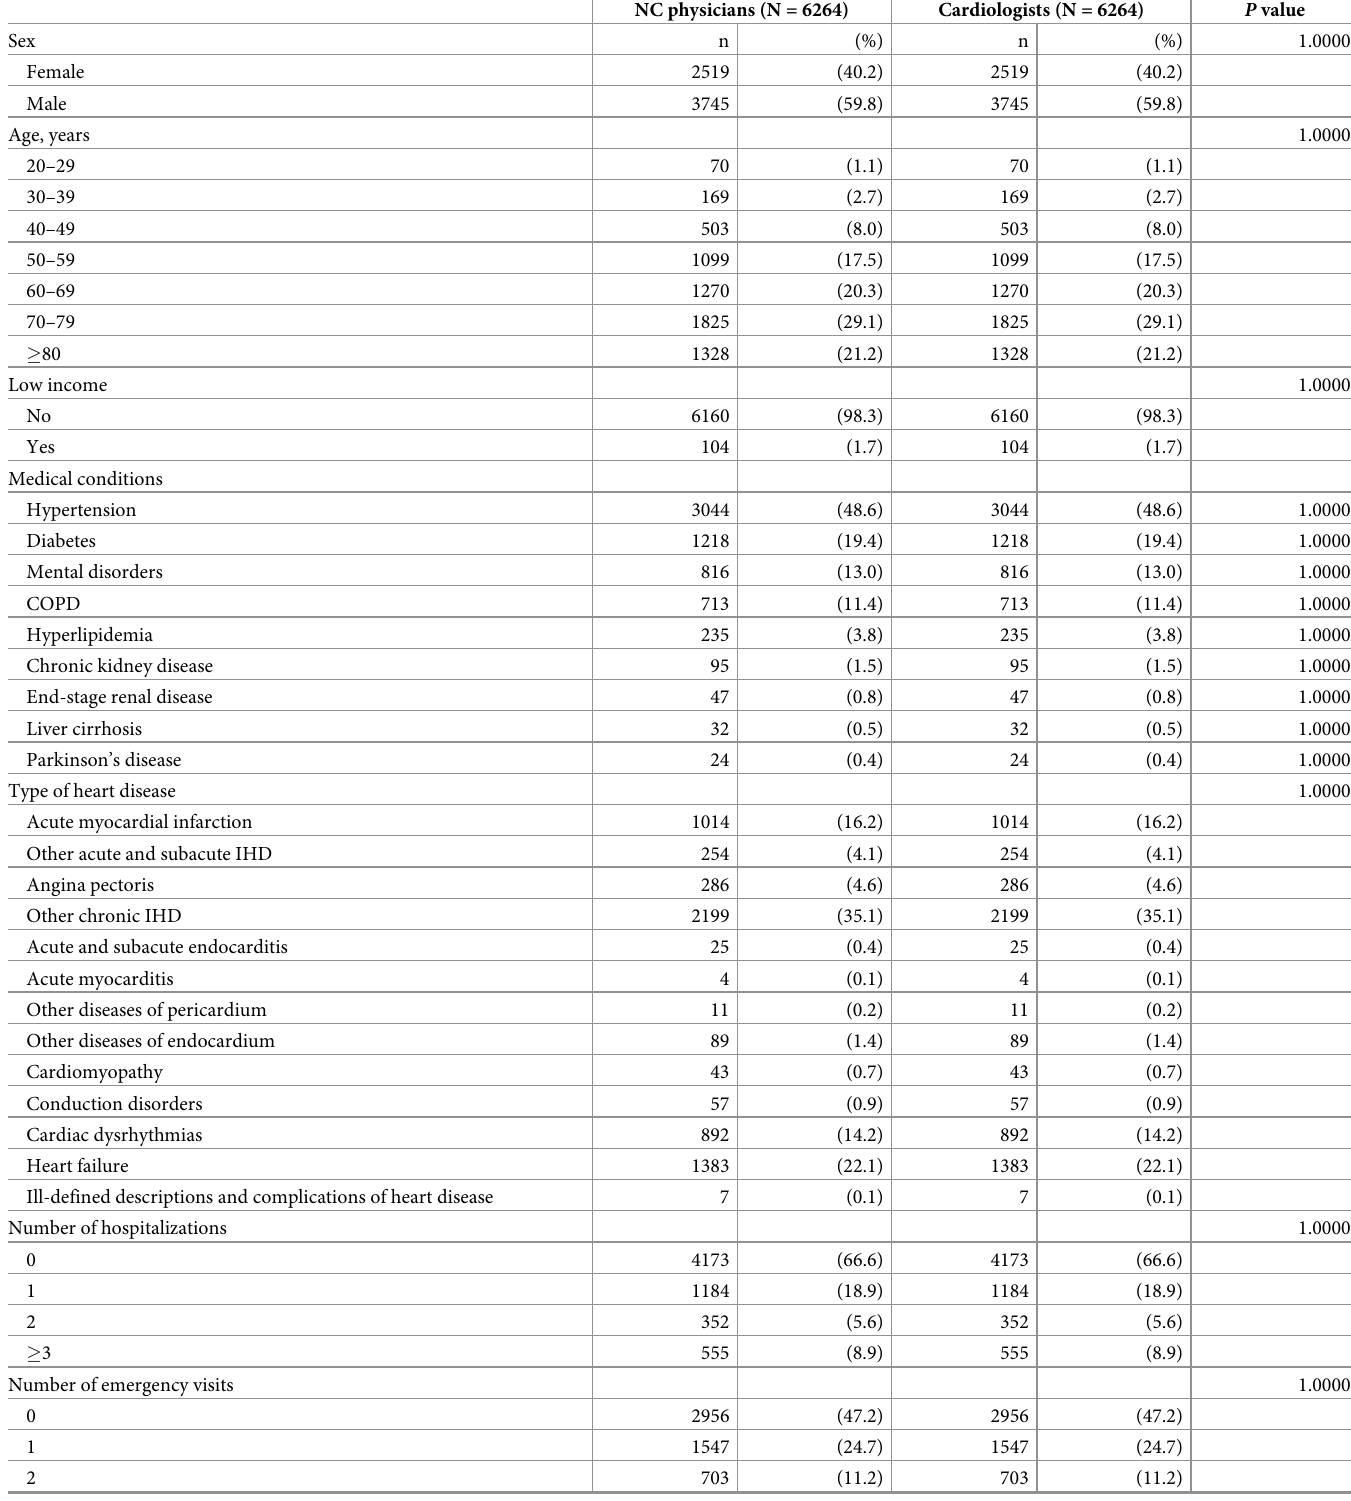
Table 1. Characteristics of patients with cardiovascular admission receiving care by cardiologists and NC